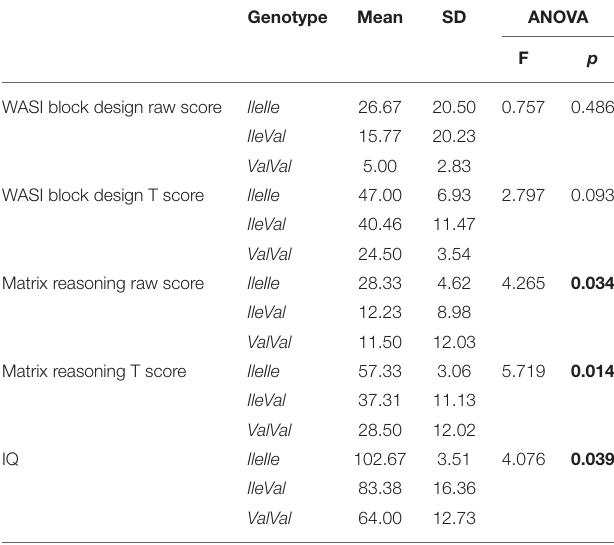
TABLE 5 | Correlation of GSTP1 genotypes and intellectual functioning.